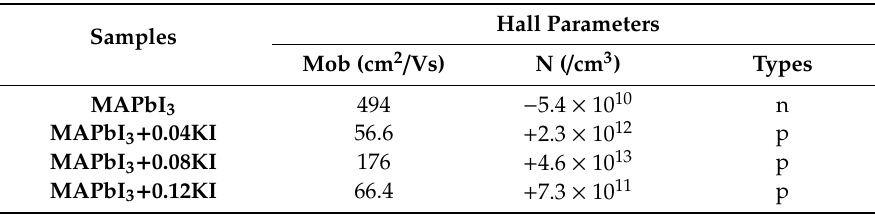
Table 2. Hall parameters of perovskite layer with di ff erent K + concentrations.